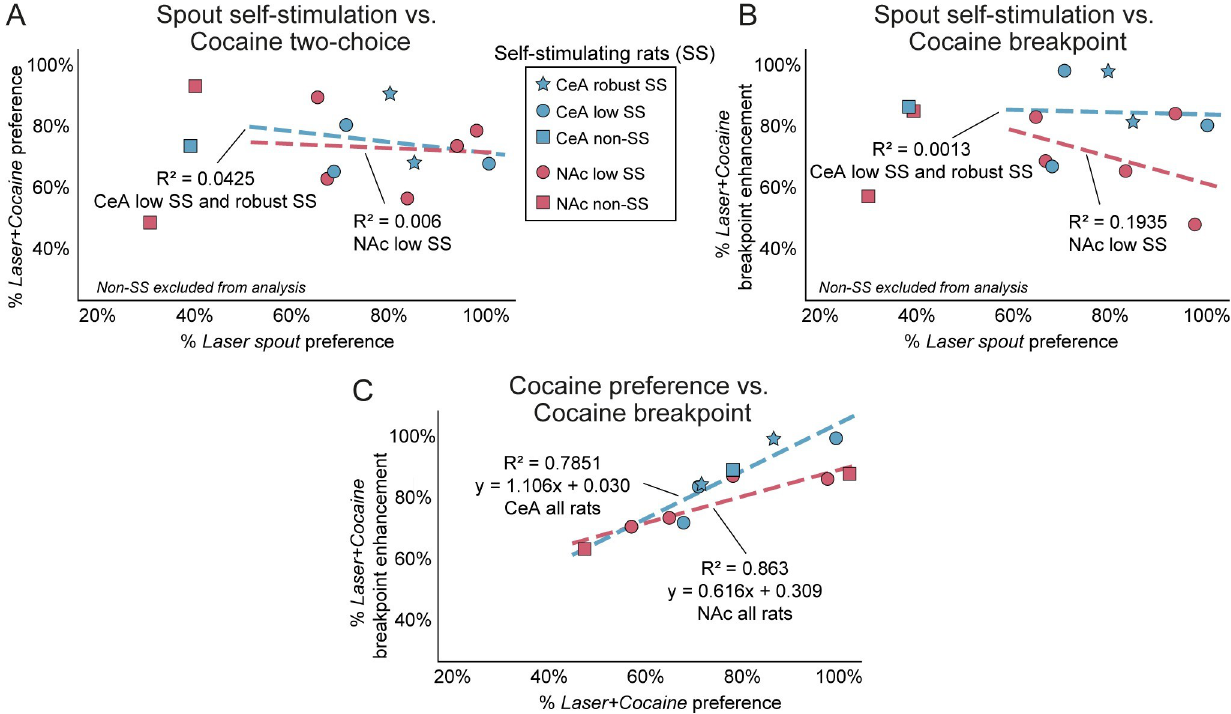
Fig 8. Laser-paired cocaine preference predicts cocaine breakpoint, not self-stimulation in NAc and CeA ChR2 rats. Laser self-stimulation by NAc ChR2 rats (red/purple squares & dashed line) or CeA ChR2 rats (blue squares & dashed line) did not correlate with their degree of laser-induced amplification of cocaine value. A) Lack of correlation between self-stimulation and paired cocaine preference in two-choice task. B) Lack of correlation between self-stimulation and intensity of paired cocaine motivation in breakpoint task. Even rats that met criteria for laser self-stimulation failed to show correlation with strength of laser-paired cocaine preference or pursuit. C) The magnitude of laser-induced increase in cocaine value was stable across both progressive ratio and two-choice tasks for NAc ChR2 and CeA ChR2 rats, as indicated by a simple linear regression analysis. Regression lines with β - coefficients and R 2 values